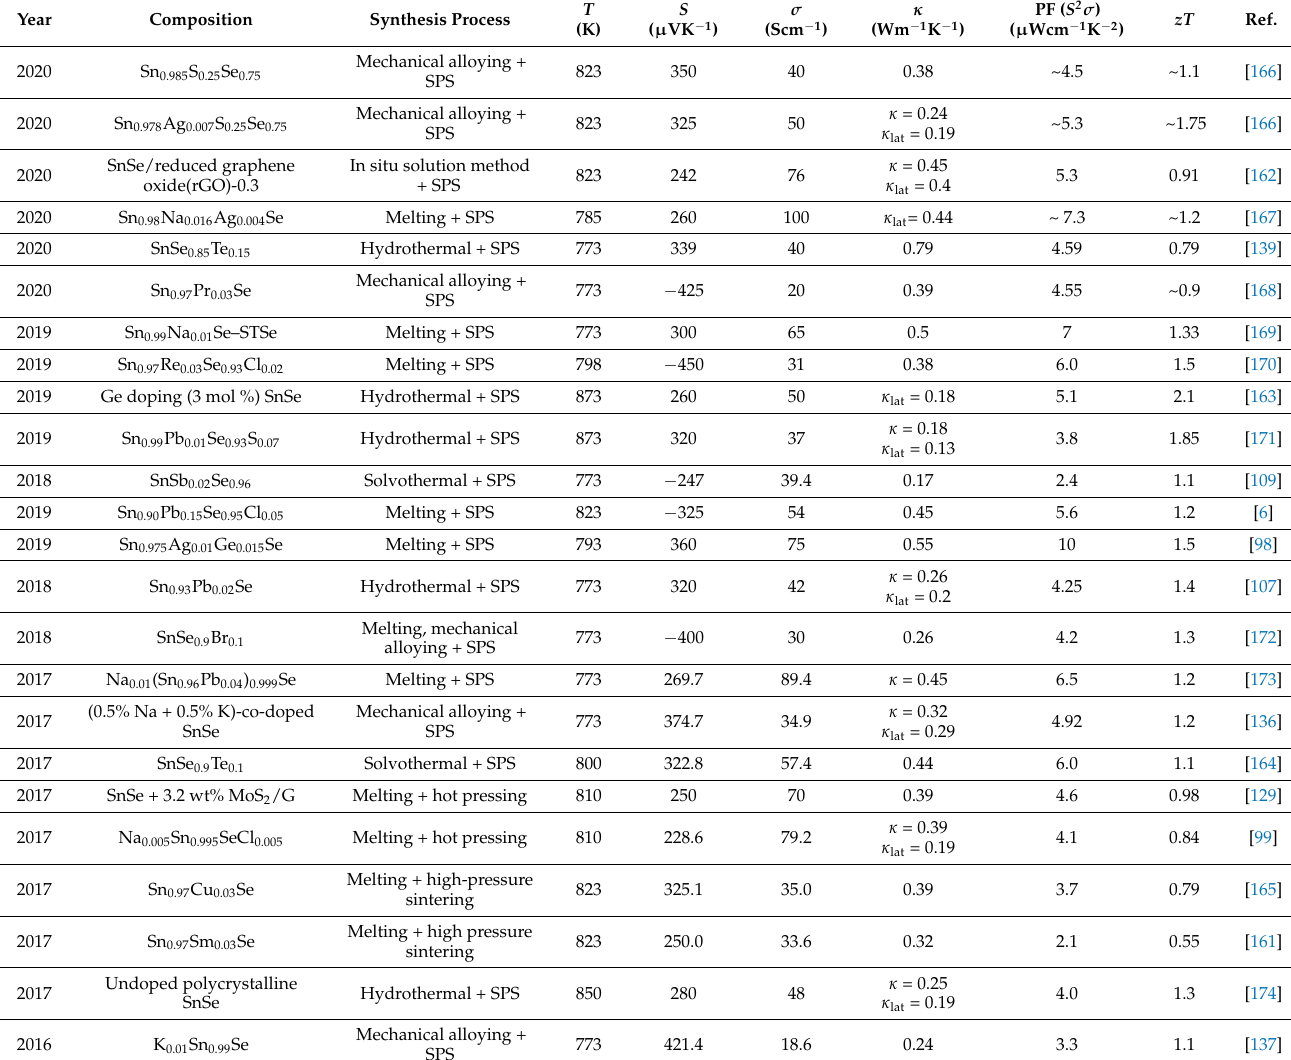
Table 5. TE properties and synthesis of SnSe by simultaneously increasing power factor and reducing lattice thermal conductivity